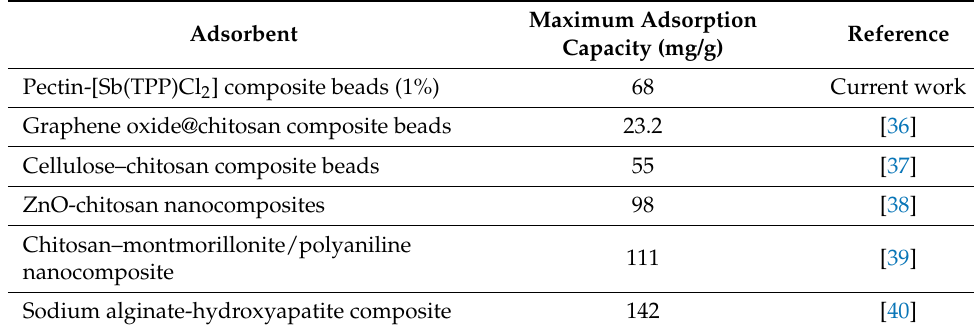
Table 2. Comparison of the maximum adsorption capacities of methylene blue with some examples of adsorbents reported in the